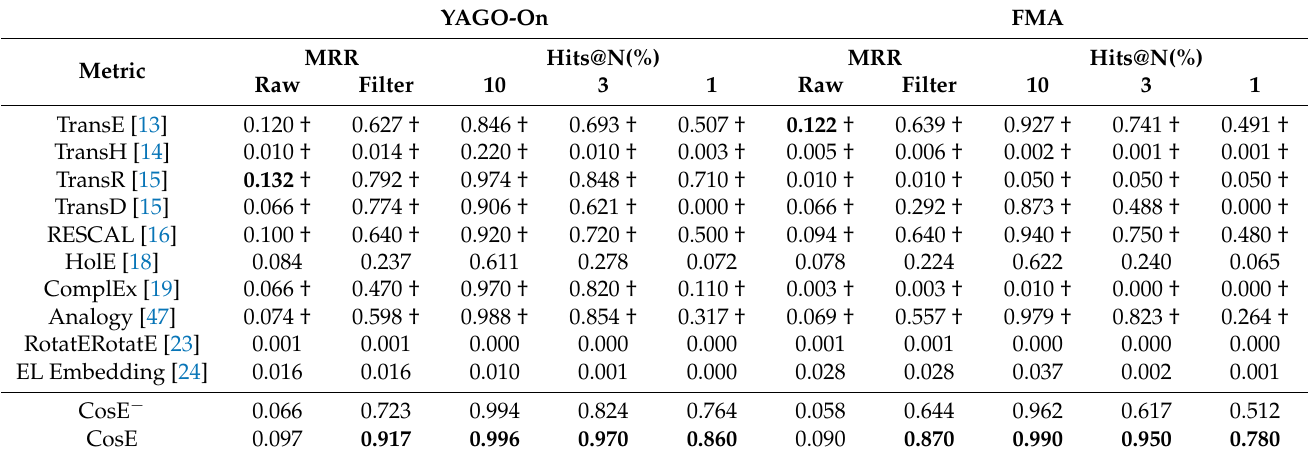
Table 6. The results of YAGO-On and FMA on link prediction about disjointWith axioms.